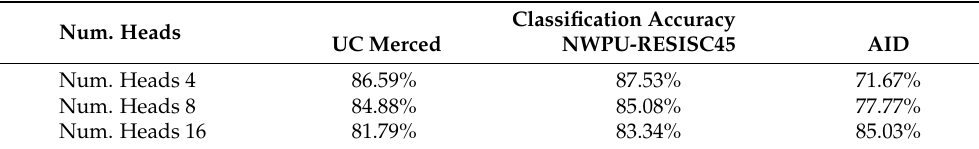
Table 7. Influences of the number of attention heads of the graph transformer on the performance. Classification Accuracy Num. Heads UC Merced NWPU-RESISC45 AID Num. Heads 4 86.59% 87.53%